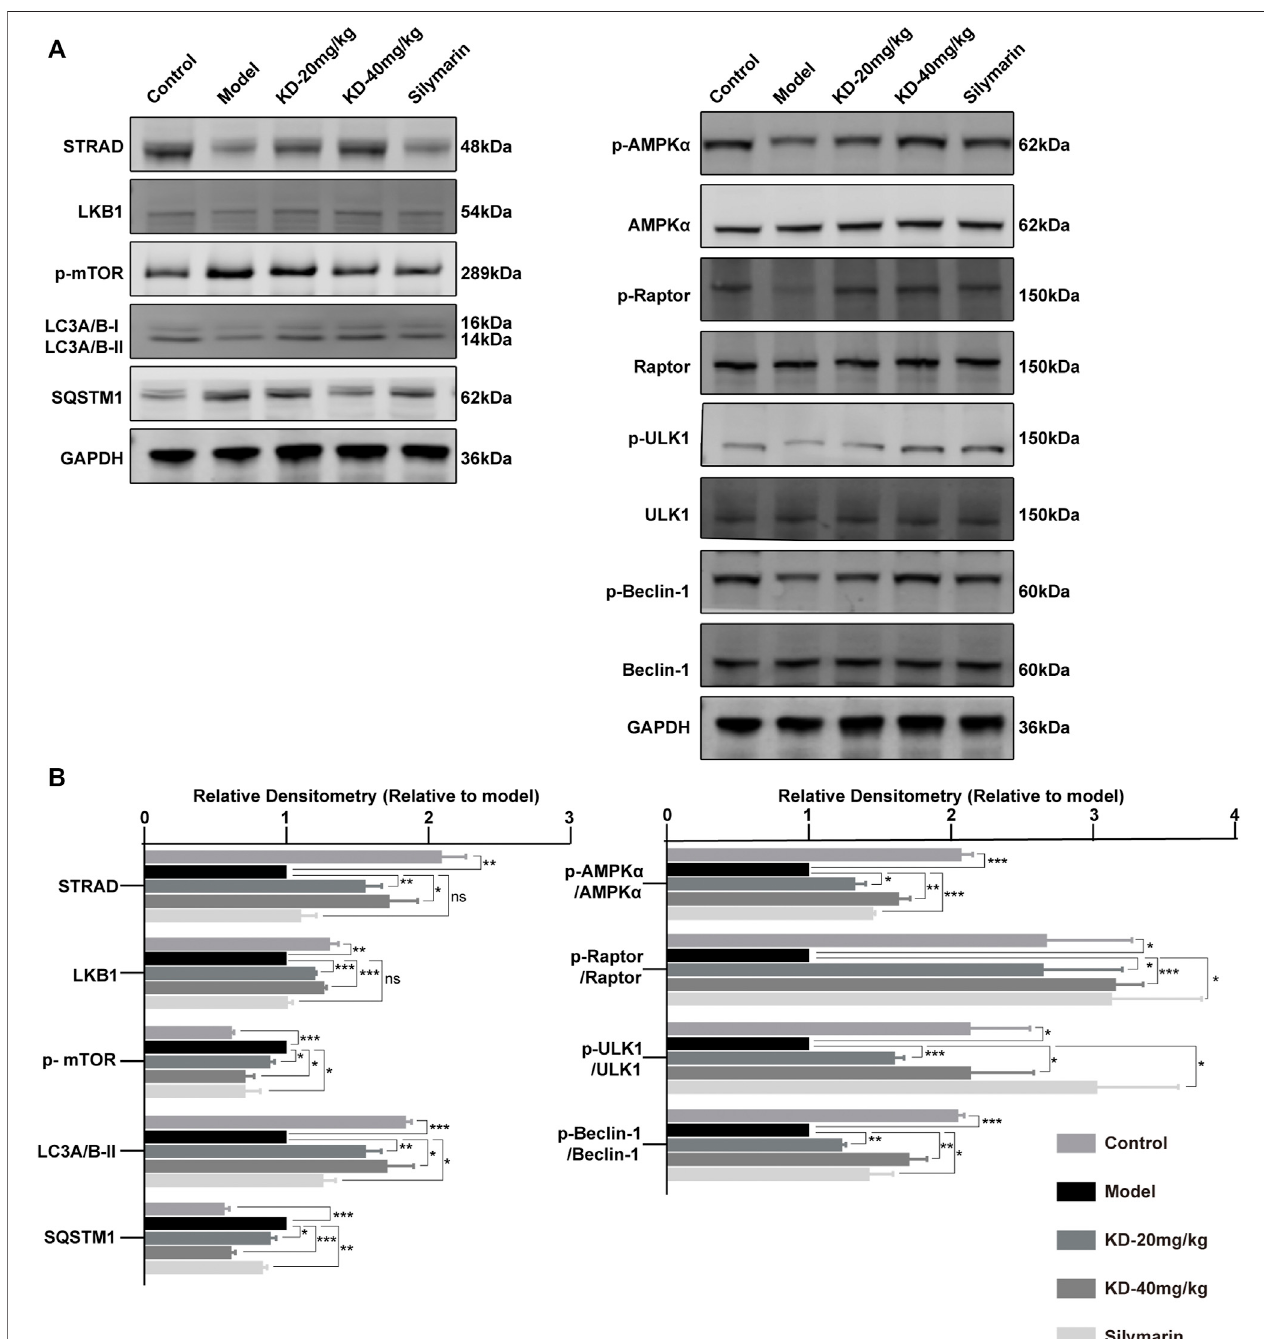
FIGURE7| Activation ofAMPK-dependentprotectiveautophagy inKD-treated mice withalcoholicliverinjury. (A) LevelsofAMPKand autophagy-related proteins determined by western blotting. (B) Quantitative analysis of protein expression ( n (cid:1) 3). Data represent the mean ± SEM. GAPDH was used as a loading control. ns, not signi fi cant. * p < 0.05, ** p < 0.01, *** p < 0.001 vs. the model